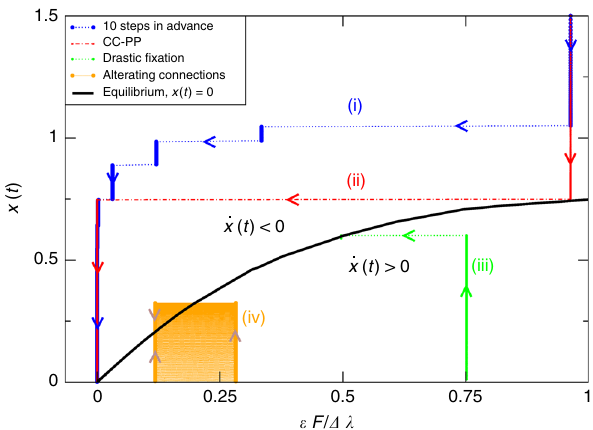
Fig. 3 Population fl ux diagram. We propose this tool for the analysis of generic evolutionary processes on two connected networks out of the equilibrium. It is noteworthy that the normalised connection strength plotted in the X-axis depends on the connector links, whereas the Y-axis represents the population distribution x ð t Þ . In consequence, the evolution of a process towards the equilibrium, where changes in the connector links between networks are permitted at any time, becomes a path in the population fl ux diagram composed of vertical and horizontal lines. For clarity, four different trajectories are plotted for two connected scale-free networks (see caption of Fig. 1 for networks which are still far from equilibrium, show the fastest dynamics (top-left corner of b and d).